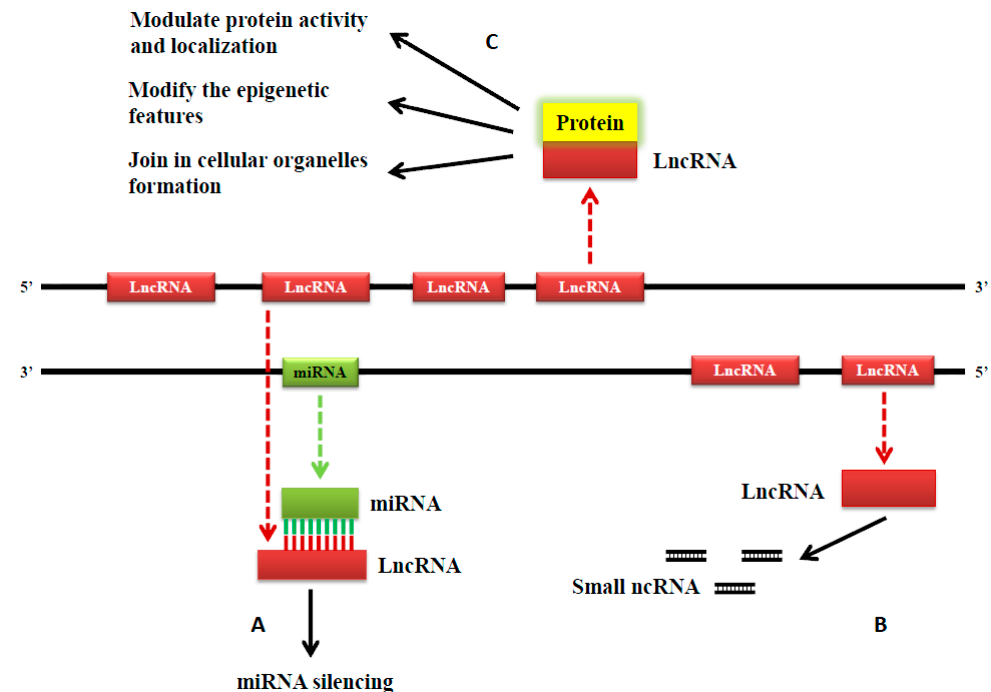
Figure 3. Schematic illustration of lncRNAs functioning at a post-transcriptional and epigenetic level. ( A ) LncRNA can silence miRNA by binding to it; ( B ) LncRNA can be precursors of sncRNA; and ( C )